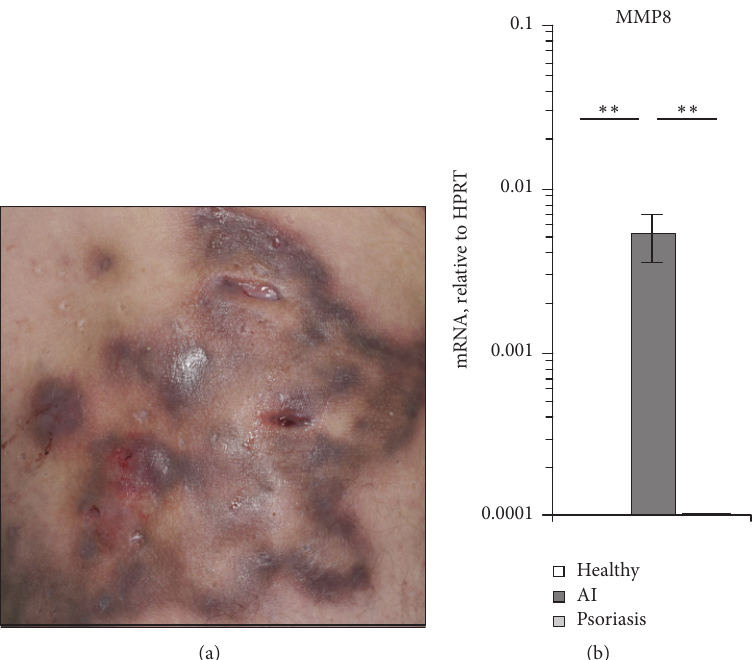
Figure 1: MMP8 expression is elevated in lesional skin of AI patients. (a) Picture of affected gluteal skin of a 53-year-old patient suffering from AI with inflammatory lesions and fistulas. (b) MMP8 expression was analyzed in biopsies from skin of 8 healthy control donors and the lesional skin of 10 AI and 10 psoriasis patients by RT-qPCR. Mean data ± SEM are shown. Significance of differences was analyzed using the Mann-Whitney U test (two-tailed; ∗∗ 𝑃 < 0.01